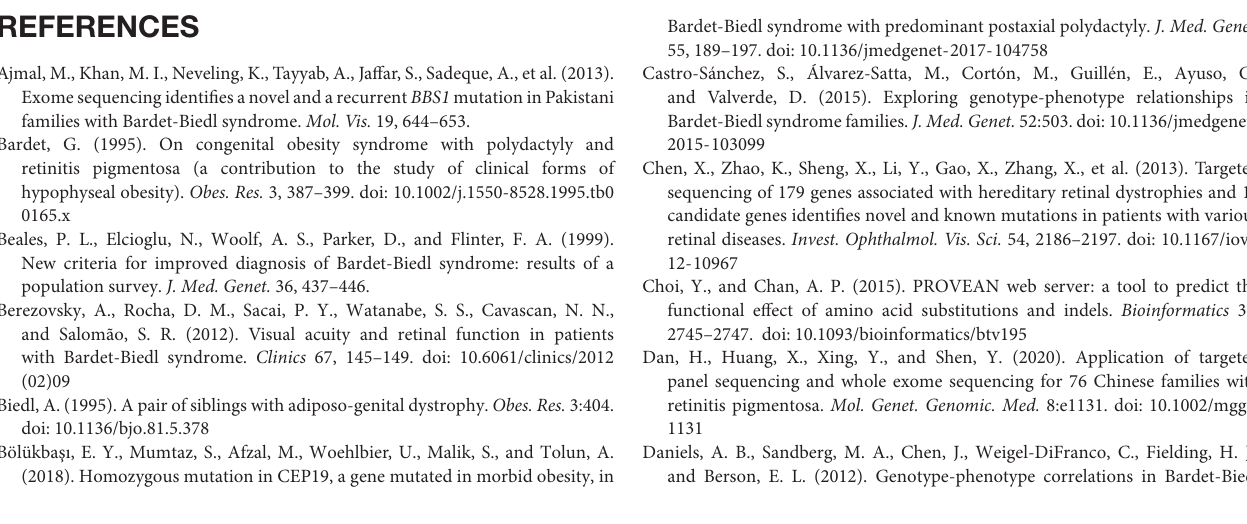
Supplementary Figure 1 | The mfERG recordings in patients with BBS. The mfERG waves were unrecordable in all patients accessed. Supplementary Figure 2 | PVEP recordings in patients with BBS. The PVEP results showed a severely decreased amplitude and moderate delayed peak time in the P100 wave of BBS patient F6-II:1, while the other patients had unrecordable PVEP due to nystagmus and fixation loss. Supplementary Figure 3 | Sanger sequencing of disease-causing variants were identified in BBS patients. Supplementary Table 1 | 131 inherited retinal disease genes analyzed by targeted NGS diagnostic